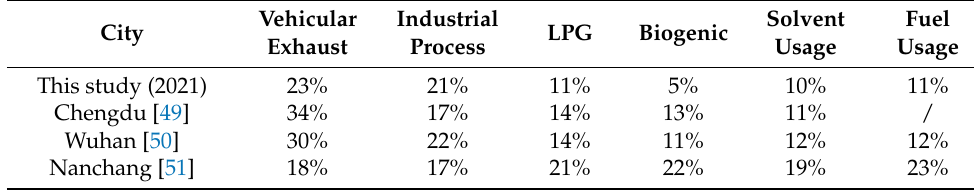
Table 4. PMF source analysis results of other cities in